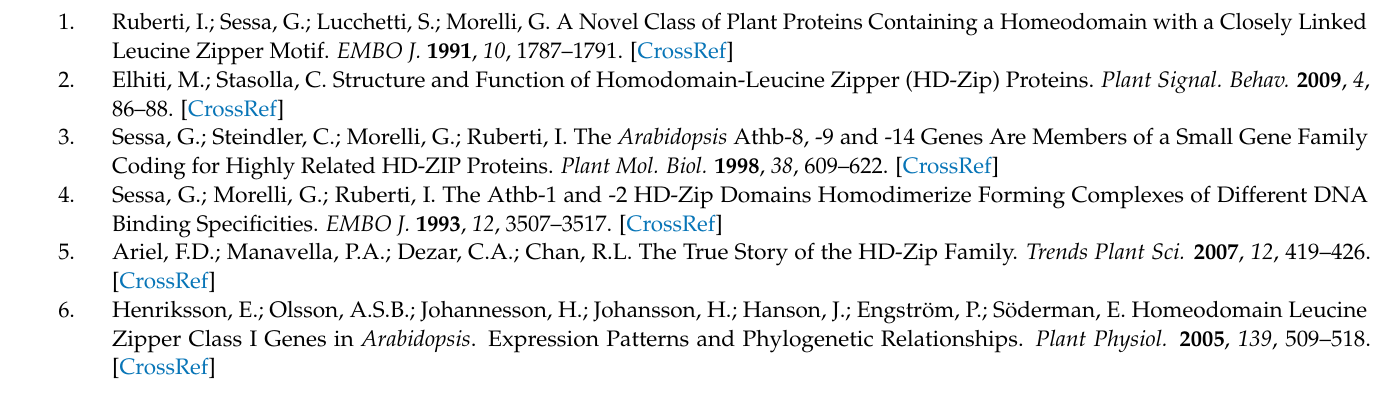
Table S1. Primer sequences in this study; Table S2. Information on the HD-Zip genes identified in the three species of Brassica ; Table S3. HD-Zip genes identified in the eight B. napus varieties. ZS11, Gangan (GG), Zheyou7 (ZY), Shengli (SL), Tapidor (TA), Quinta (QU), Westar (WT), and No2127 (NO); Table S4. The four duplicated types of HD-Zip genes in the three species of Brassica ; Table S5. Syntenic gene of HD-Zip genes in A. thaliana and the three species of Brassica ; Table S6. Ka/Ks ratios of HD-Zip orthologous pairs; Table S7. The Cis-acting elements in the promoter regions of BnHD-Zip